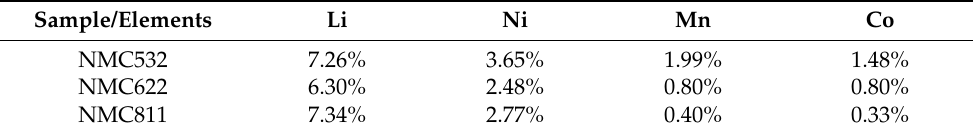
Table 4. Content of metals of interest in the obtained slag phase (mass fraction, wt.%).